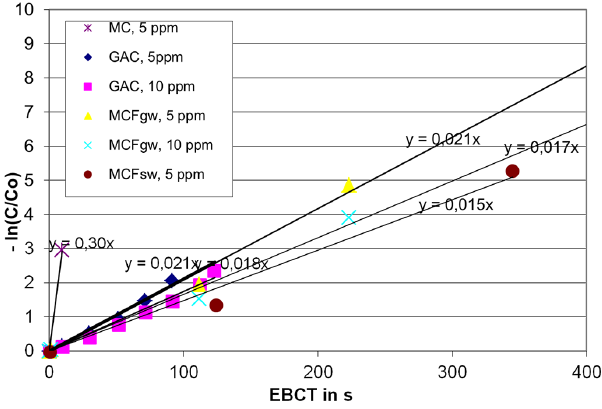
Figure 5. Conversion rate constants of the different tested catalysts.